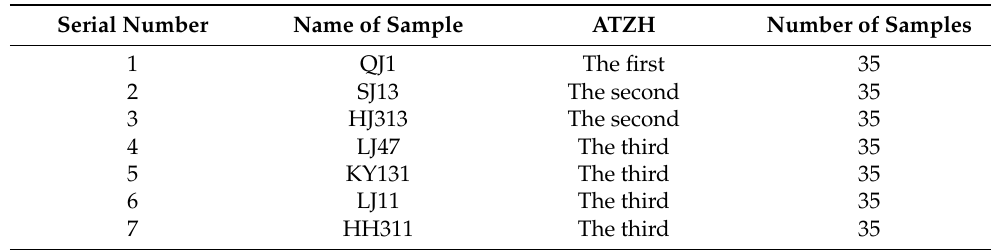
Table 1. Appropriate accumulated temperature zone and quantity of test samples (ATZH: accumula- tion temperate zone in Heilongjiang Province).